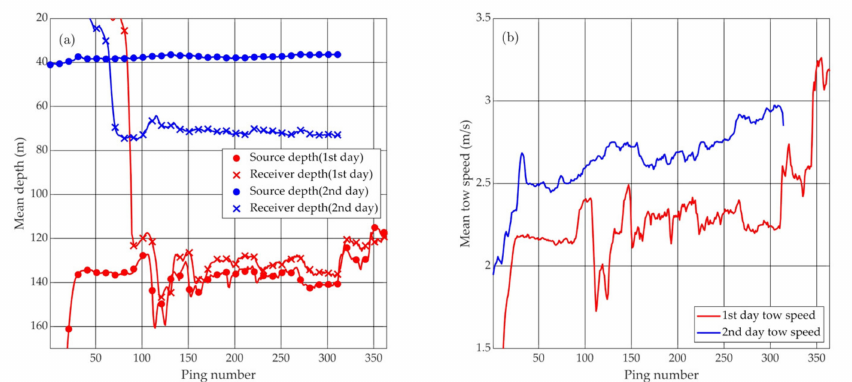
Figure 4. ( a ) Mean operation depth of the source and receiver array for each ping number. ( b ) Mean